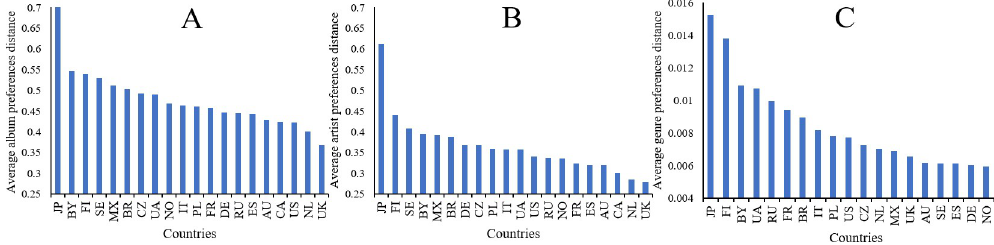
Fig 5. The average between-country cosine distances of music preferences. (A): distances of album preferences; (B): distances of artist preferences; (C): distances of genre